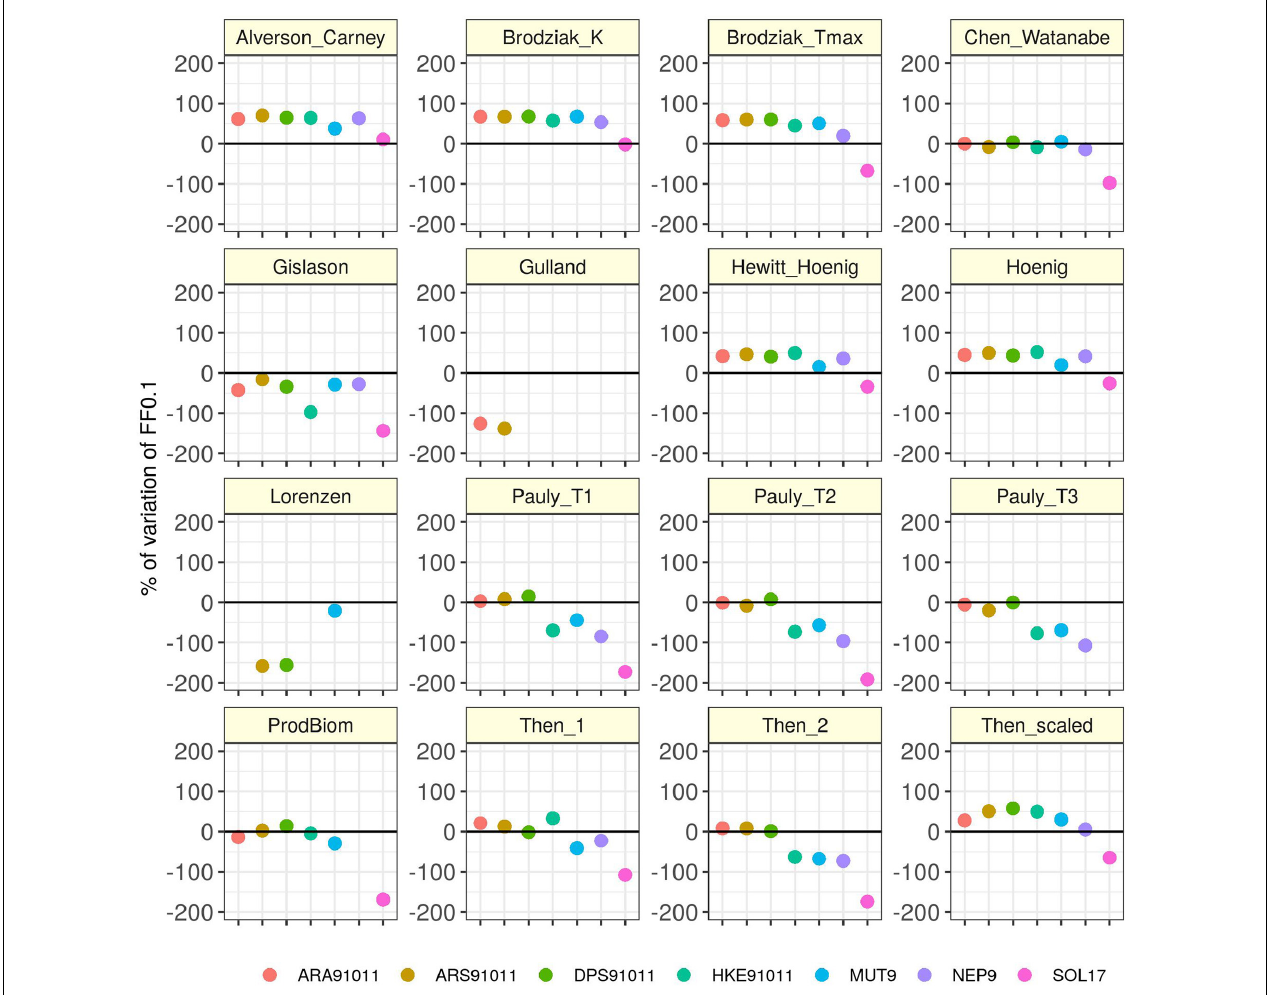
FIGURE 5 | Relative error (%) of F curr /F 0 . 1 respect on the baseline [the official STECF assessment advice (black line)]. Percentages more than 200 and less than –200 are not shown (see Table 4 for